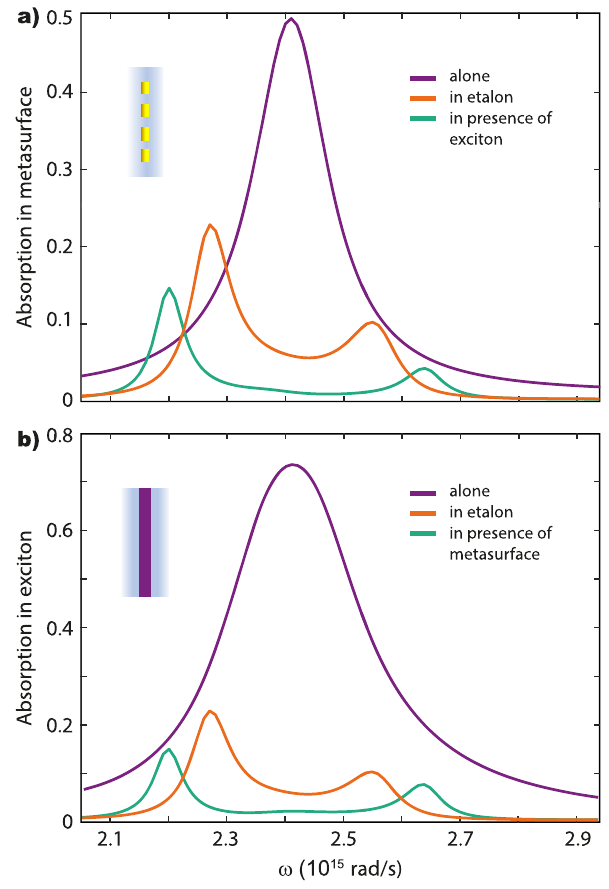
Figure 13: Absorption spectra of (a) a plasmonic metasurface, resp. (b) an excitonic medium (J-aggregate), considering them in isolation (purple curves centered on the resonance ω 0 (cid:1) 2 . 4 ⋅ 10 15 s − 1 ), inserted into an etalon (orange curves), resp. when in the tripartite system of etalon, exciton, and plasmonic metasurface. Parameters are as inFigure 12, with the etalonopening d fi xed suchthat the fi rst order bare etalon resonance is at ω 0